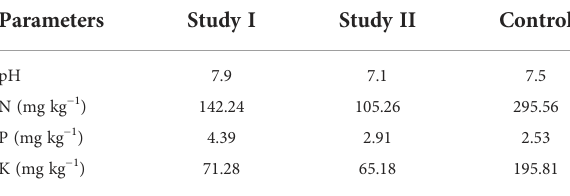
TABLE 3 Signi fi cant changes in the quantity of essential elements and pH in treated soil compared with control.